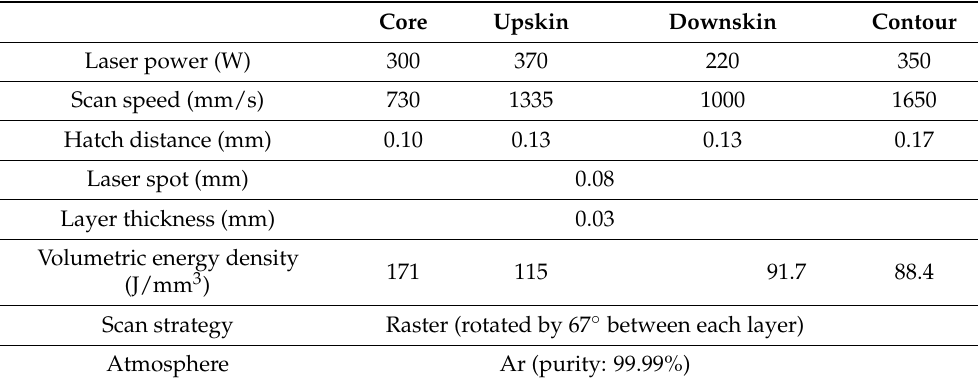
Figure 3. SEM image (250×) and chemical composition of the AlSi10Mg powder feedstocks used for the L-PBF process. Table 1. L-PBF process parameters used in this study.